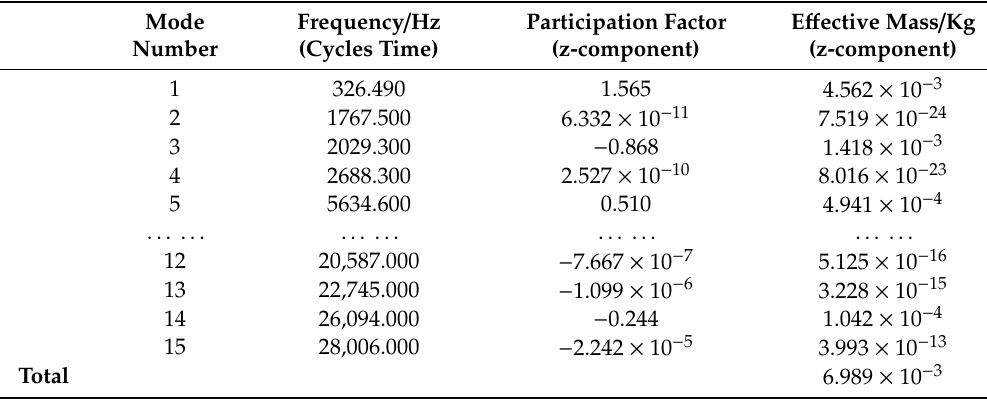
Table 3. Frequency, participation factor and e ff ective mass for 15 eigenvalues.